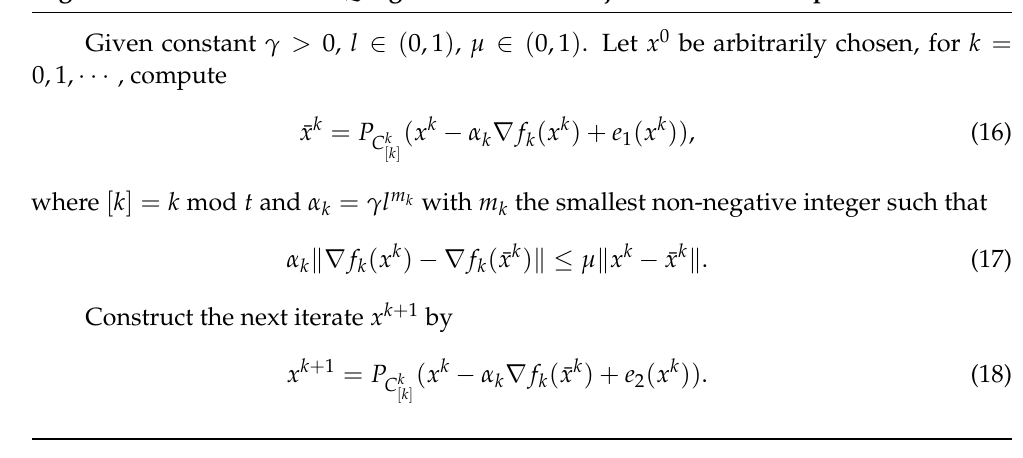
Algorithm 1 (The relaxed CQ algorithm with Armijo-line search and